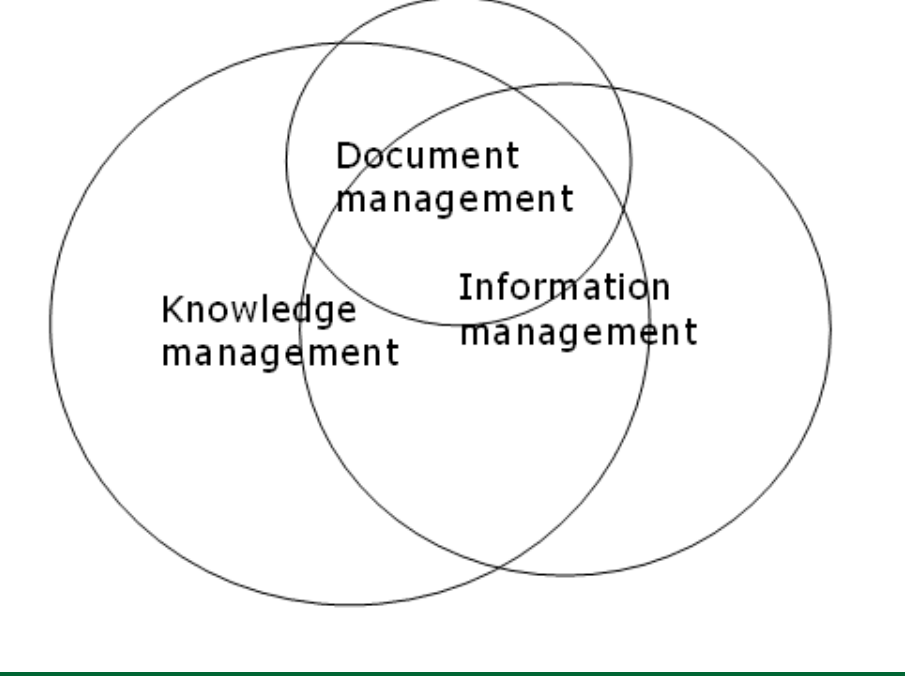
Figure 4 Interrelationship between document management information management and knowledge